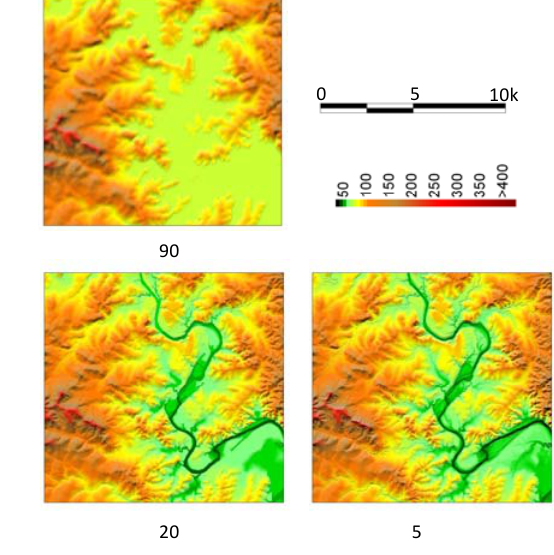
Figure 3. 90, 20 and 5 m